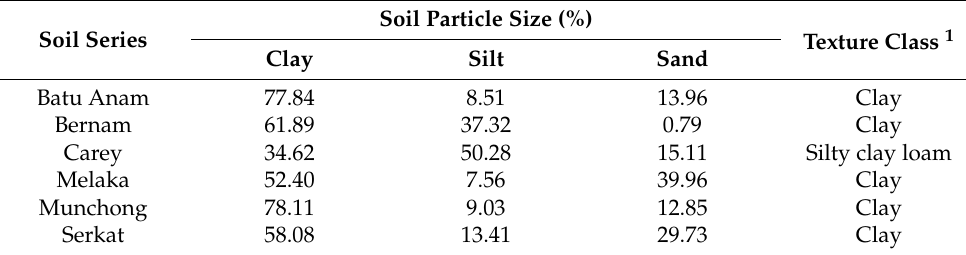
Table 2. Soil particle size analysis of six soil series.